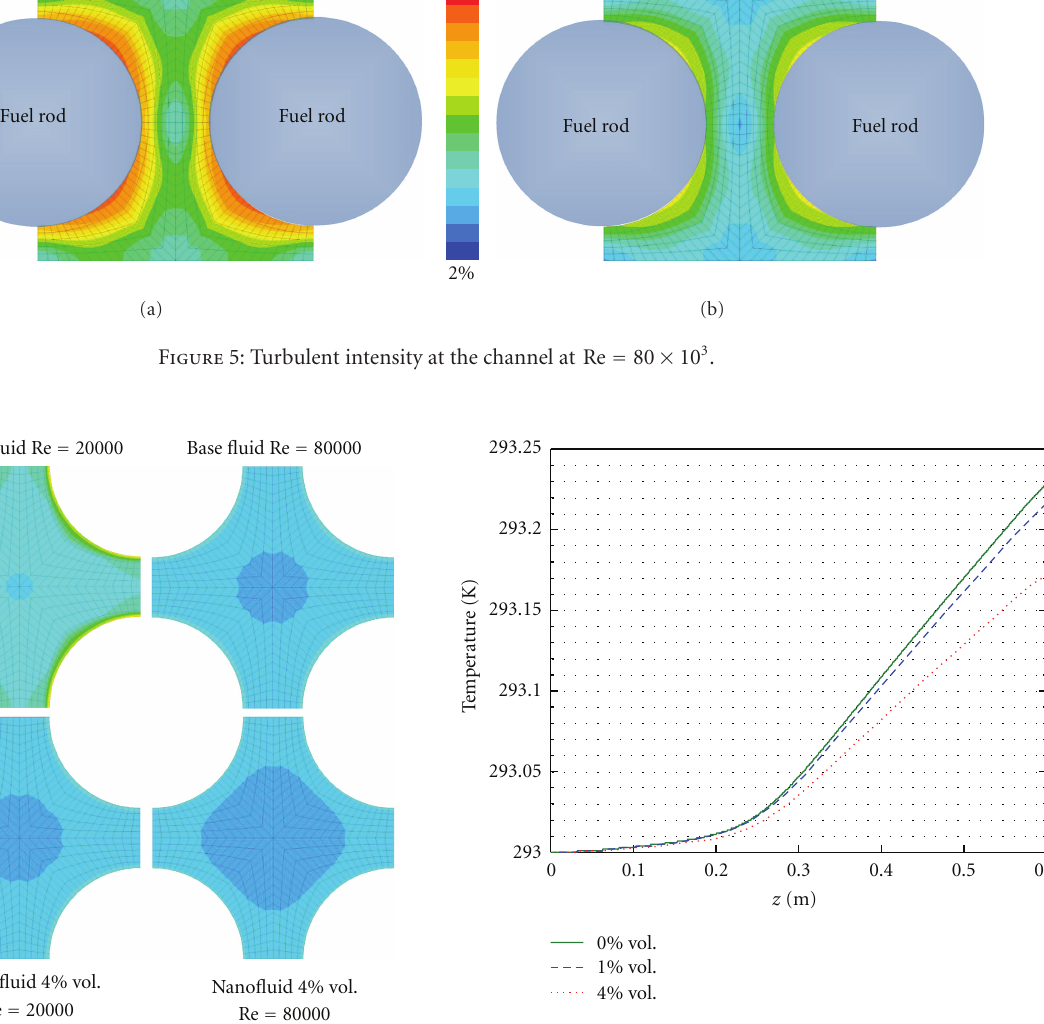
Figure 6: Temperature profile at the outlet for base fluid and nanofluid and Re = 20 × 10 3 and 80 × 10 3 .